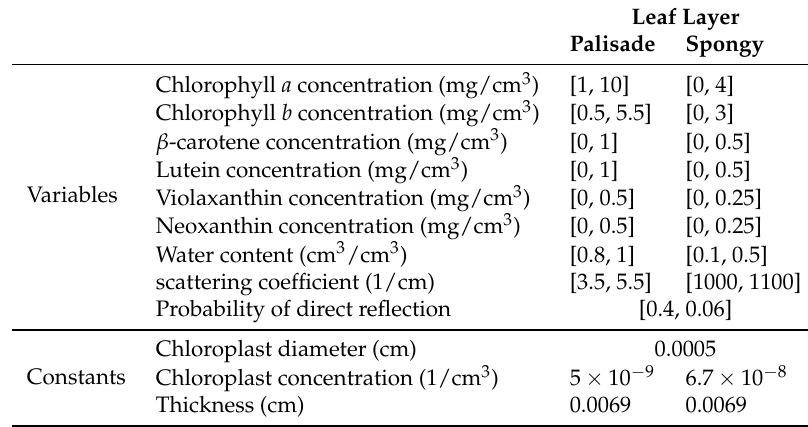
Table 1. Constants and variables used in making training, testing, and validation data with SLOP. The training, testing, and validation data consist of 500,000 spectra made with SLOP. Each spectrum is produced by taking a random value from each interval in the table and calculating SLOP for each specified wavelength. The spectra are divided into training, testing, and validation data randomly, with constant